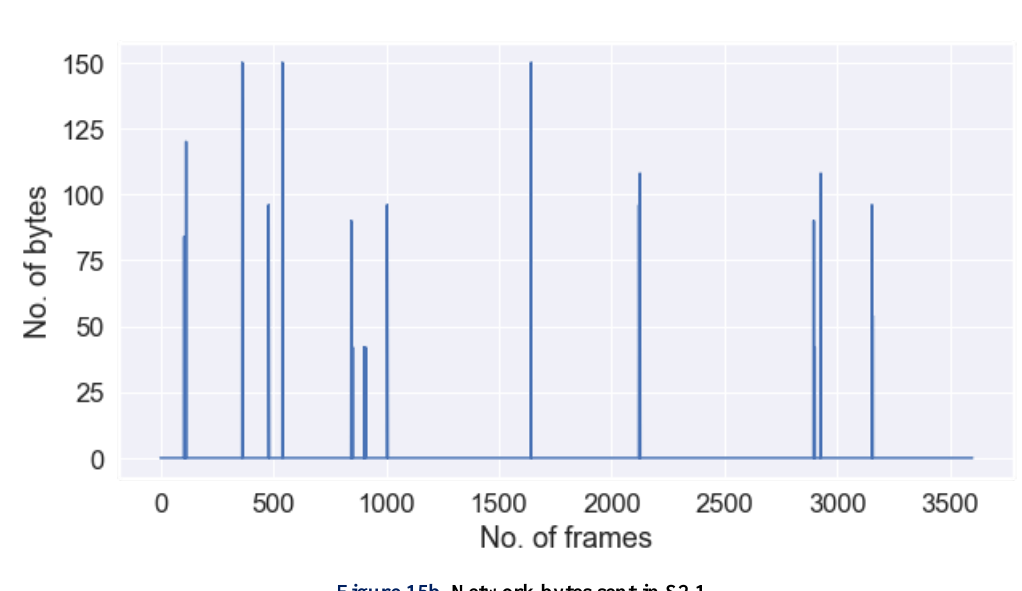
Figure 15a. Network bytes received in S2.1.